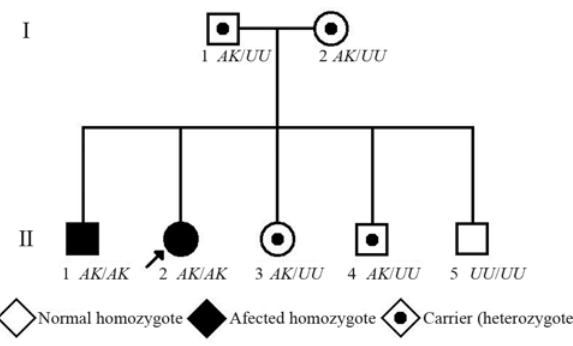
Figure 1 - Pedigree of the studied family.